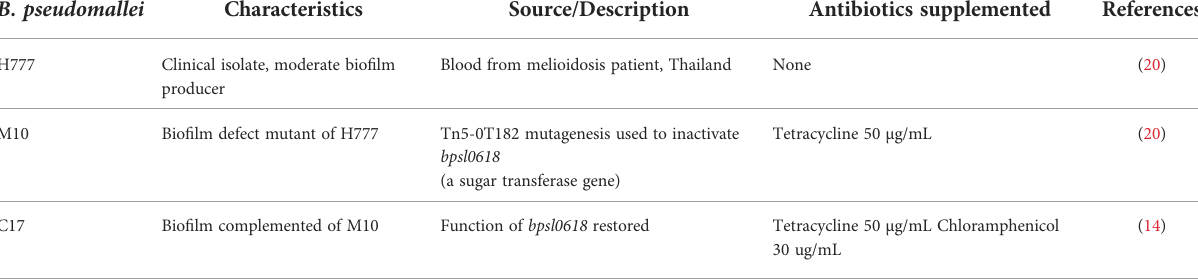
TABLE 1 B. pseudomallei